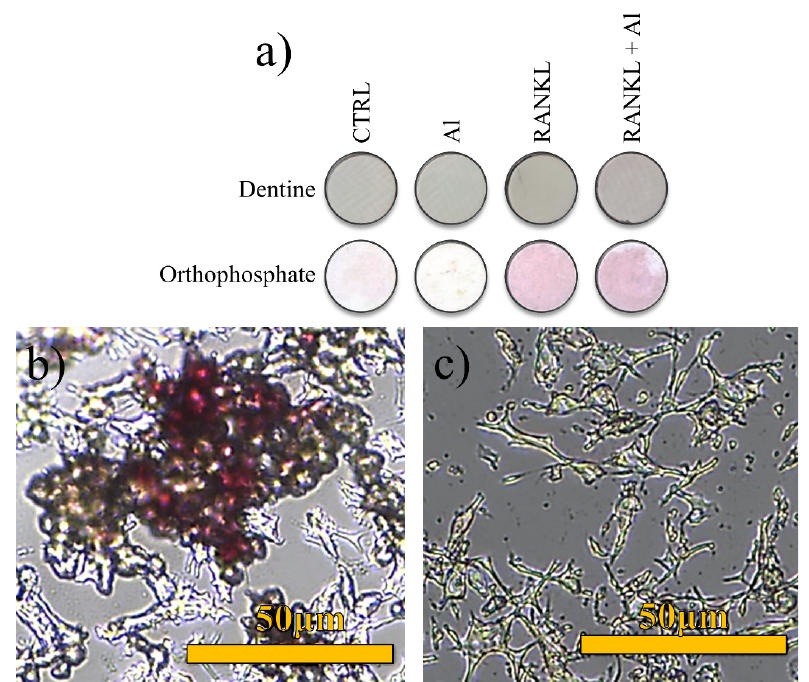
Figure 2. TRAP staining results on the different samples, as observed by optical microscopy. Color contrast has been digitally enhanced using ImageJ software: ( a ) macro images of representative samples for the eight sample groups; ( b ) optical microscope of cells differentiated by RANKL; ( c ) optical microscope of cells from a control dentine sample without RANKL. Both ( b , c ) show cells collected from samples and deposited on glass substrate for optical analysis.